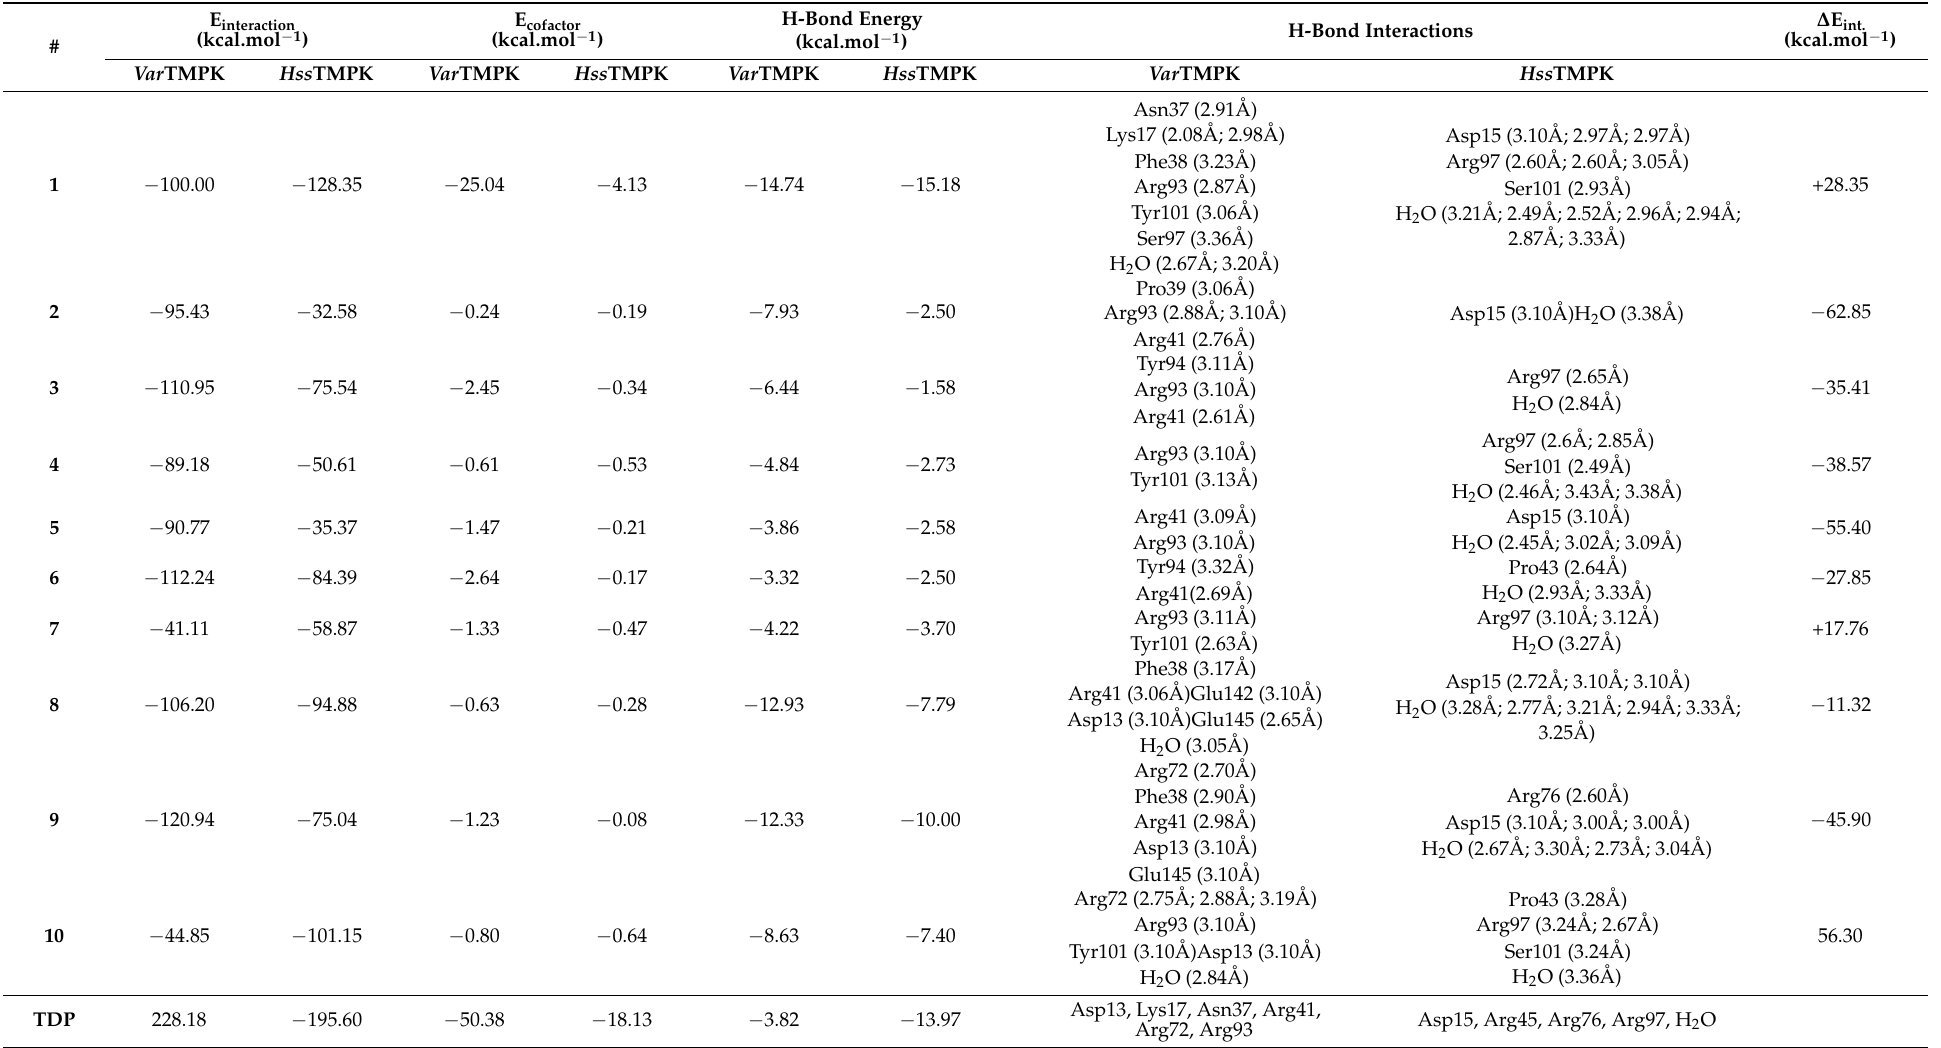
Table 3. Docking results for the compounds studied and TDP inside Var TMPK and Hss TMPK active